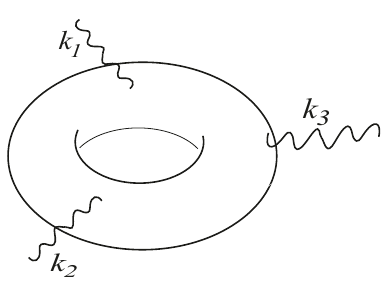
Figure 1 . Three graviton scattering with two massless gravitons with momentum k 1 ; k 2 and a KK state carrying momentum k 3